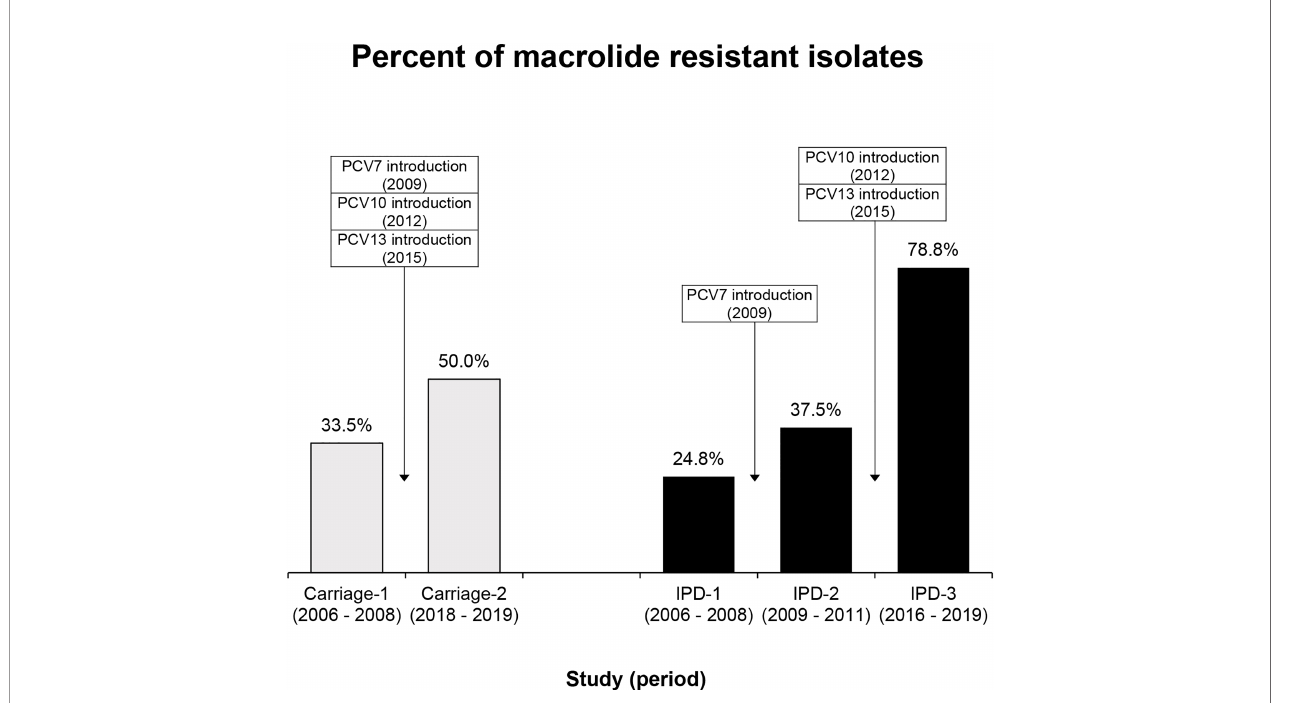
FIGURE 1 | Proportion of macrolide resistance in S. pneumoniae isolates in Carriage and IPD studies conducted from 2006 to 2019 in Peru. Carriage-1 (105/313), Carriage-2 (104/208), IPD-1 (25/101), IPD-2 (21/56) and IPD-3 (67/85). Statistical signi fi cance among carriage and among IPD studies is